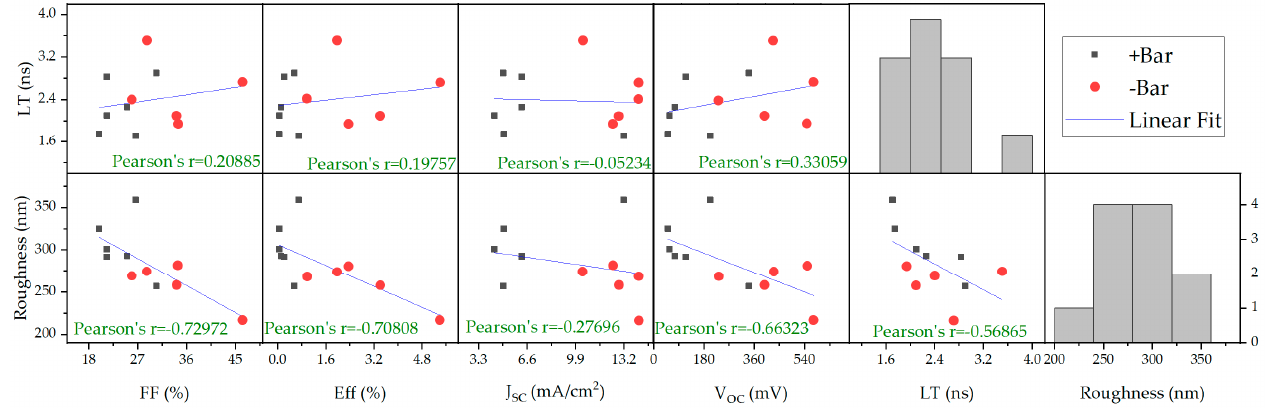
Figure 6. Scatter matrix plot for the pairs of metrics annotated with Pearson’s coefficient (r).